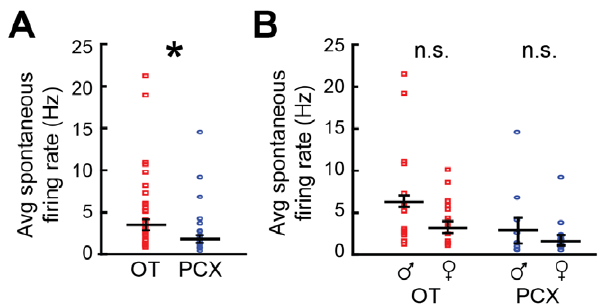
Figure 2. Spontaneous multi-unit activity in the OT and PCX. ( A ) Average spontaneous firing rates of OT (left) and PCX units (right). Each point represents average within units of 2 sec prior to odor, across 4–6 trials ( n =30 OT units, 25 PCX units). Horizontal bars=average 6 SEM. * p , 0.05, 2-tailed t -test. ( B ) Average spontaneous firing rates of males and female units within the OT (left) and PCX units (right). Same data as in (A). Horizontal bars=firing rate average across units 6 SEM. n.s.= p . 0.05, 2-tailed t -test.